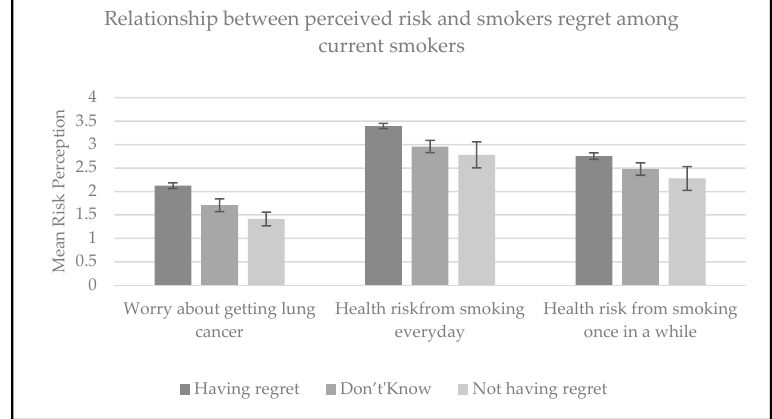
Figure 1. Smokers’ regret and their perception of harm from smoking. Higher means indicate higher perceived risk.